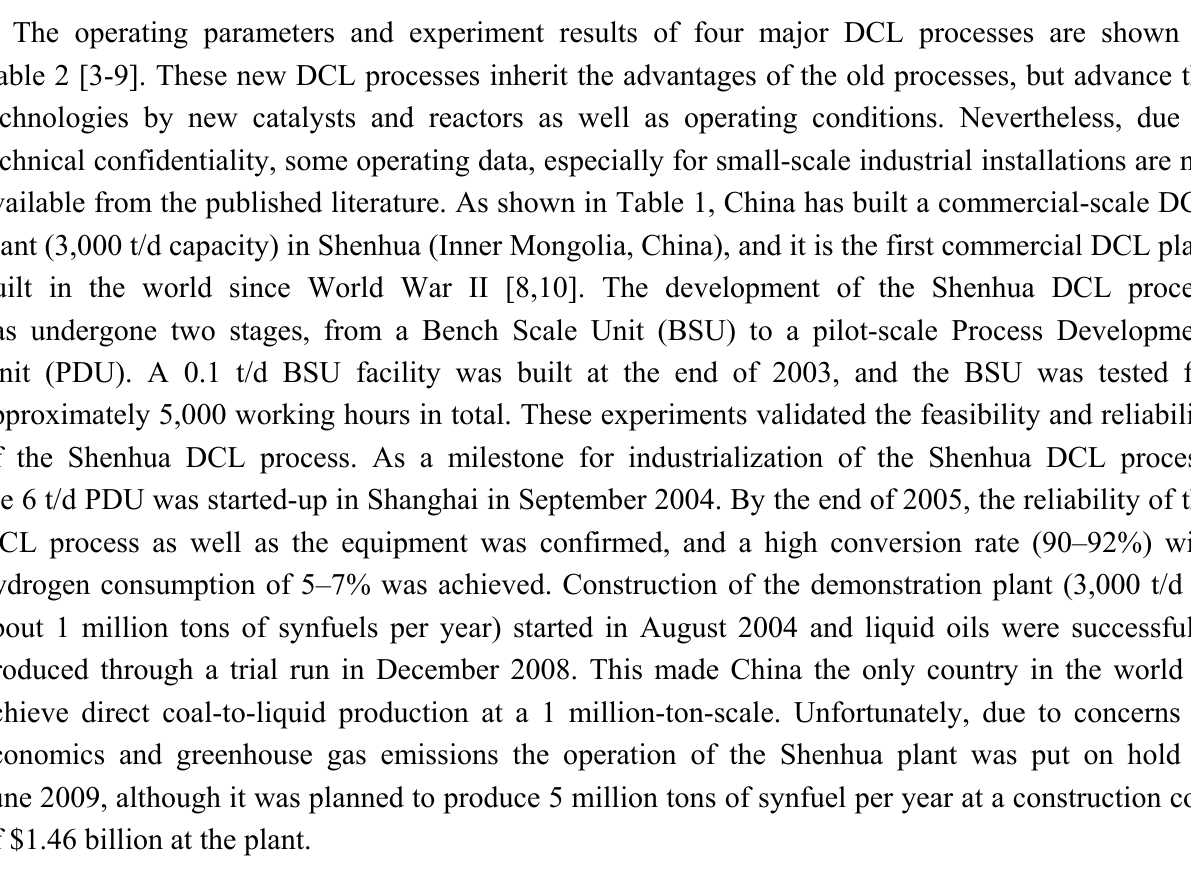
Table 2. The operating parameters and experiment results of some major DCL processes [3-9]. Process